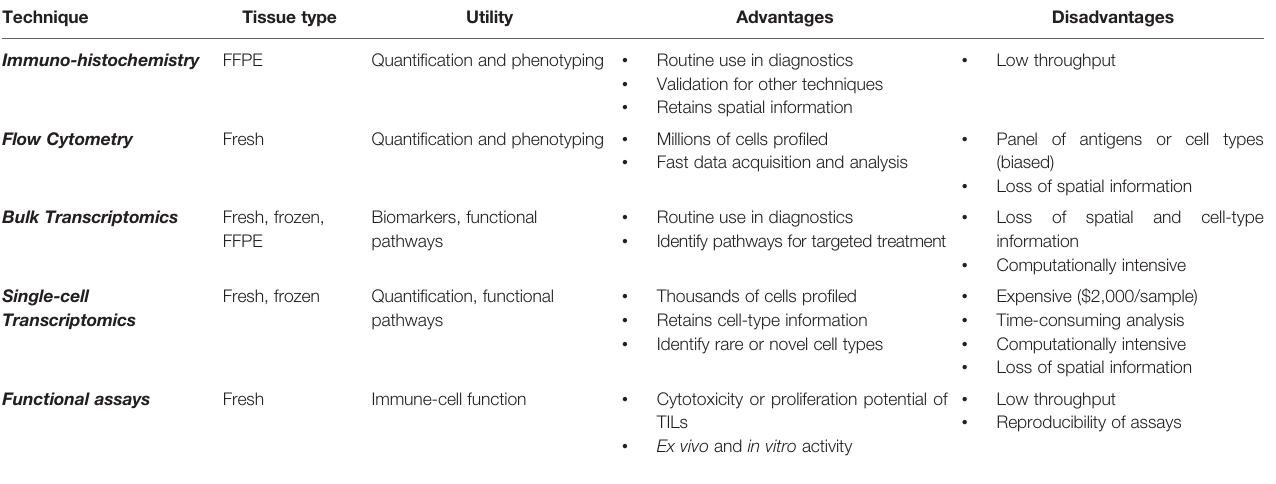
TABLE 2 | Utility and feasibility of selected techniques for immune pro fi ling of tumor tissue.